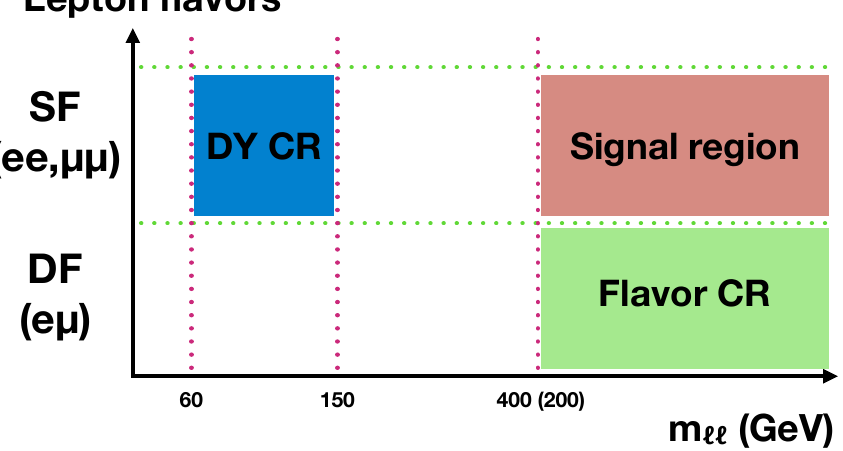
Figure 2 . A schematic diagram of the analysis region. The minimum values of the dilepton mass in the SR and the flavor CR is 400 (200) GeV for the resolved (boosted) region. The backgrounds from tW and tt production are estimated from the flavor CR (green), where different flavor (DF) leptons are required. The DY background is estimated from the DY CR